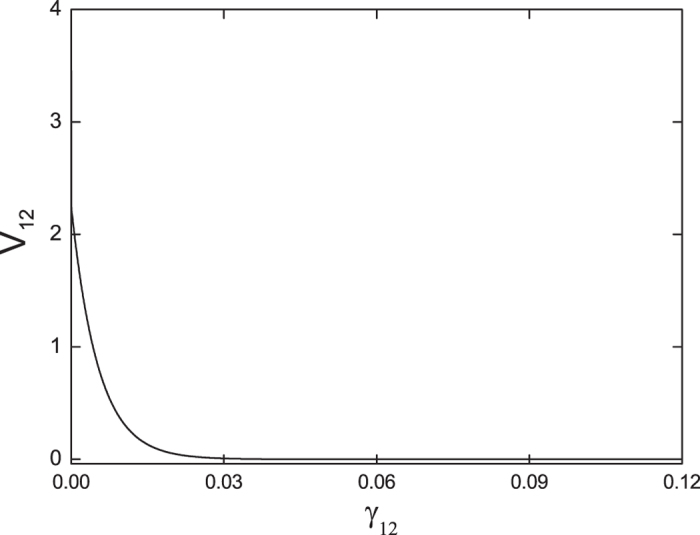
The dependence of the correlation V12 at zero Fourier frequency on the dephasing rate γ12 with n = 1 × 1019, α2 = 20α1 = 20, and the other parameters are the same as those in Fig. 2.